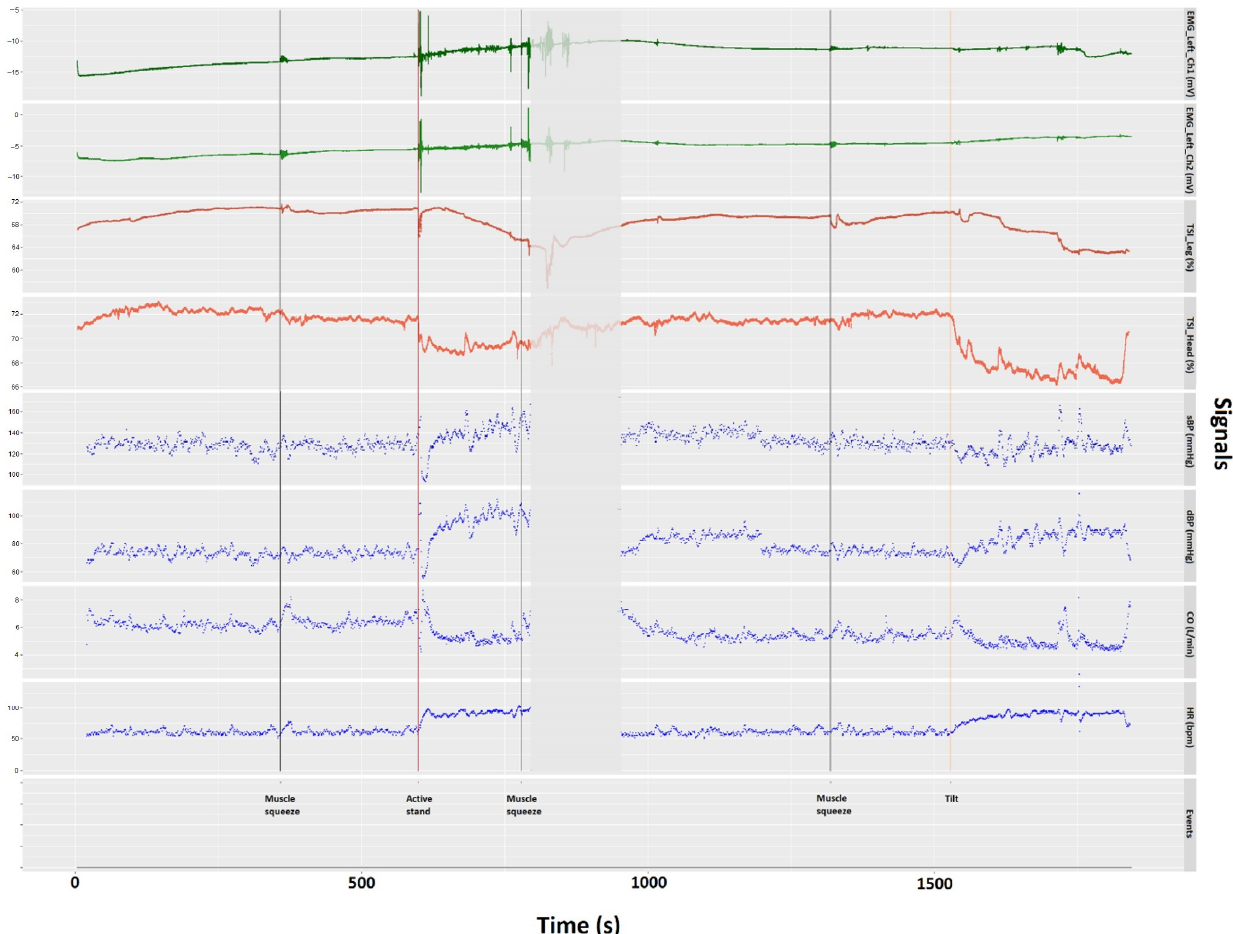
Figure 5. Visualization of integrated signals recorded from different instruments used in the NCVI/NMFI assessment, including the EMG amplitude of the left vastus lateralis (EMG_Left_Ch1) and rectus femoris (EMG_Left_Ch2), the TSI of the left thigh (TSI_Leg) and the left forehead (TSI_Head), the systolic blood pressure (SBP), the diastolic blood pressure (DBP), the cardiac output (CO), and the heart rate (shown as HR) of a participant. The vertical lines indicate the time at which all events took place, including active stand, head-up tilt, and prompted thigh muscle squeezes, annotated at the bottom of the plot.